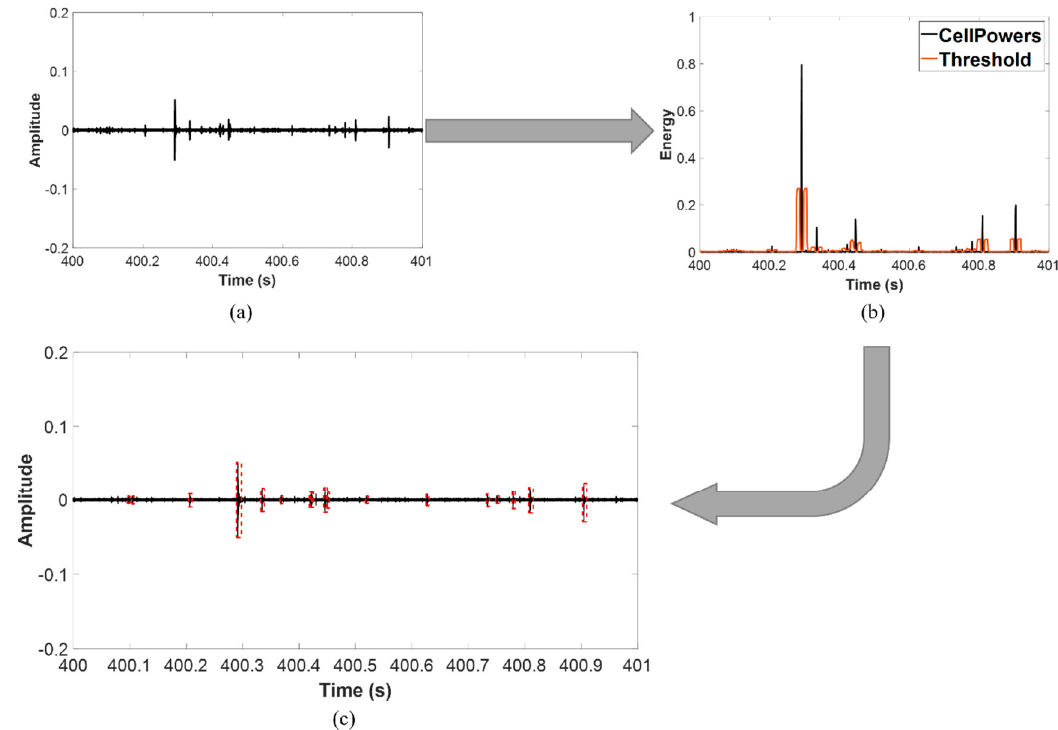
Figure 6. Application of the CFAR on sensor 8, specimen A during time steps 400–401. ( a ) Raw data, ( b ) Cell power versus threshold, ( c ) Detected hits.